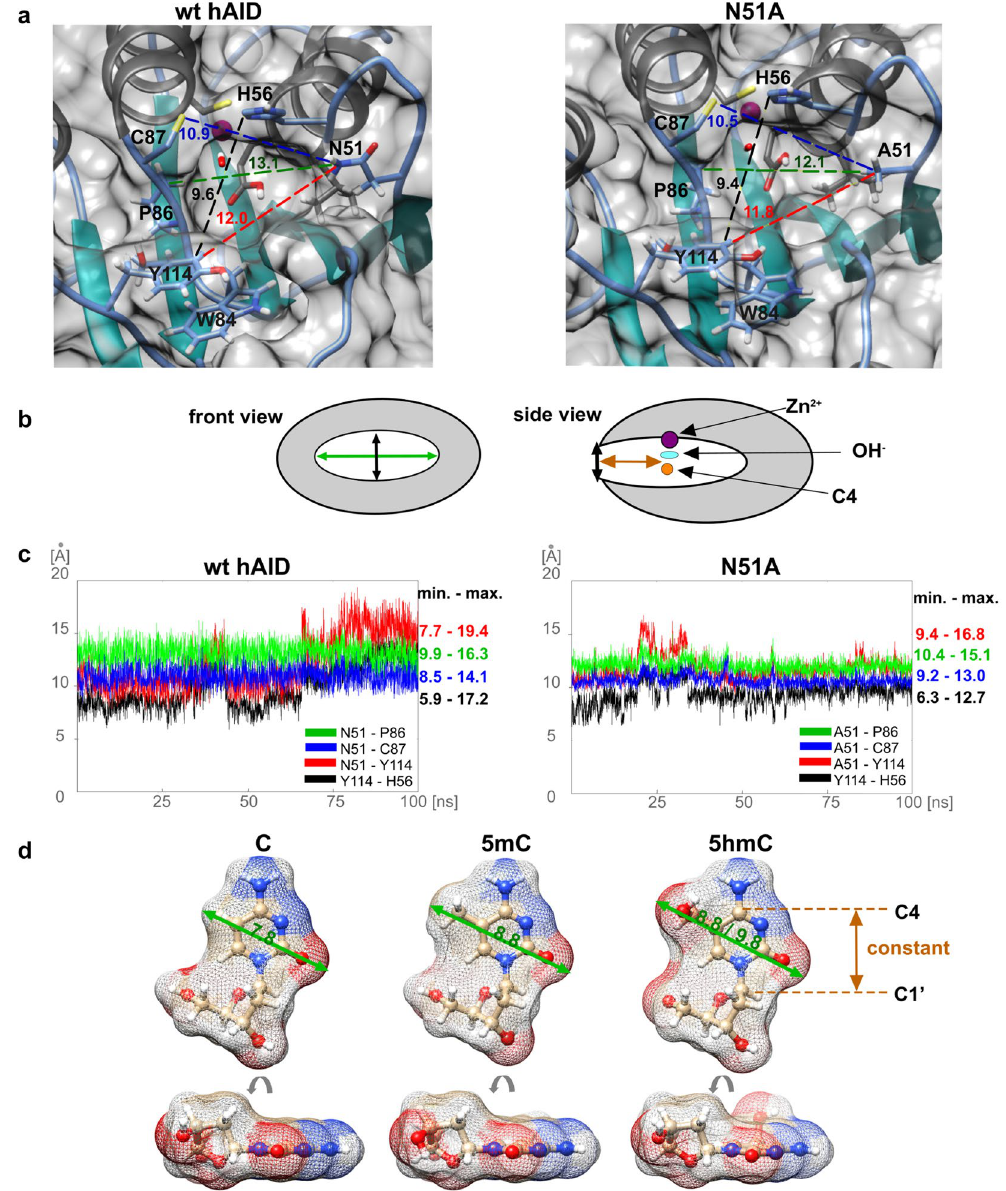
Figure 4. Comparison of the sizes of wt hAID/N51A mutant catalytic pockets with the sizes of modified and non-modified C. ( a ) Catalytic pockets of wt hAID and the N51A mutant. The size of each pocket was defined by the distances between the selected atoms that belong to four pairs of amino acid residues: N51 (A51 in the case of the mutant) and Y114 (red dashed line); N51 (A51) and P86 (green dashed line); N51 (A51) and C87 (blue dashed line); and Y114 and H56 (black dashed line). The value of each distance is indicated and expressed in Å as a mean value from the distances measured for all individual frames of the MD trajectories. The distances were determined between the following heavy atoms: ND2 atom of N51; CB atom of A51; CE2 atom of Y114; CB atom of P86, SG atom of C87, and CE1 atom of H56. ( b ) Front and side views of hAID catalytic pocket. The distance between N51 (A51) and P86, i.e., the distance determining the breadth of a heterocyclic ring that can enter the pocket, is marked by a green arrow. The distance that defines the height of the catalytic pocket (between Y114 and H56) is marked by a black arrow. The depth of the catalytic pocket is marked by an orange arrow. ( c ) Range of changes observed for each distance throughout MD trajectories. The maximal and minimal values of each distance (expressed in Å) are indicated next to the graph. The colors are the same as in panel a. (d) The breadths of the heterocyclic rings of modified and non-modified C (green arrows). The value of each breadth is expressed in Å and includes vdW radii. The distance between C1 ′ and C4 of the heterocyclic ring is constant for each of the substrates (marked by an orange arrow) and corresponds to the depth of the catalytic pockets. A side view of the substrates is also shown. Because of the rotation of the hydroxymethyl group, the ring of 5 hmC is not completely